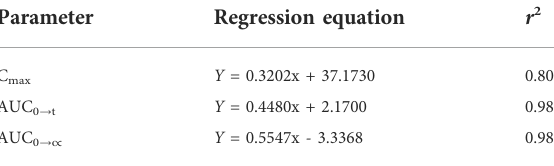
TABLE 4 Linear regression results of the means of the main pharmacokinetic parameters for three dosage groups. Parameter